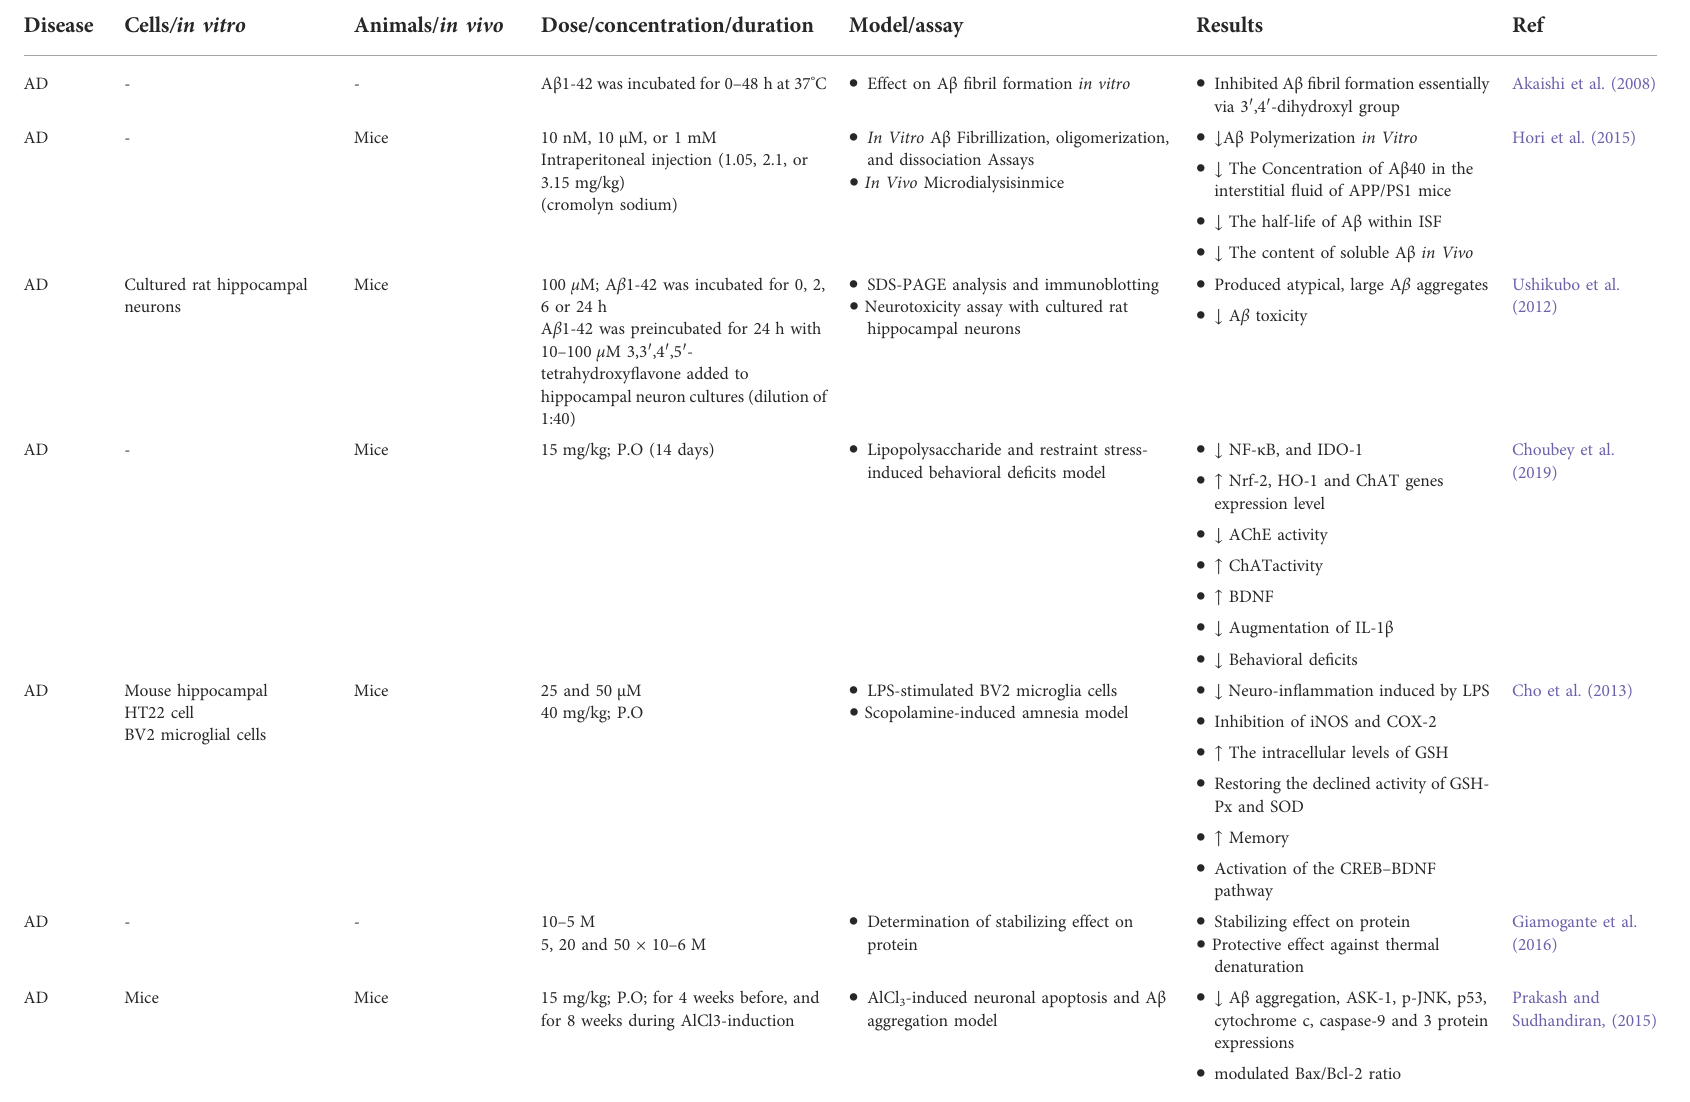
TABLE 1 Different neurodegenerative disease and the protective role of fi